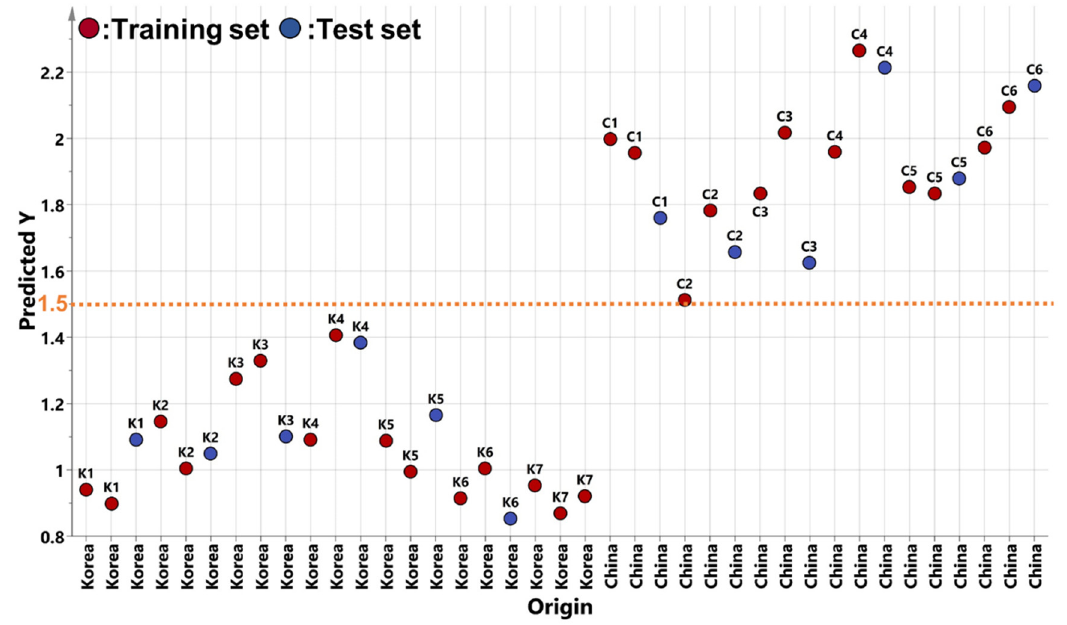
Figure 5. External validation test by OPLS–DA model of non-targeted metabolite profiling and pareto-scaling ( R 2 X = 0.371, R 2 Y = 0.868, Q 2 = 0.772, RMSEP = 0.226).